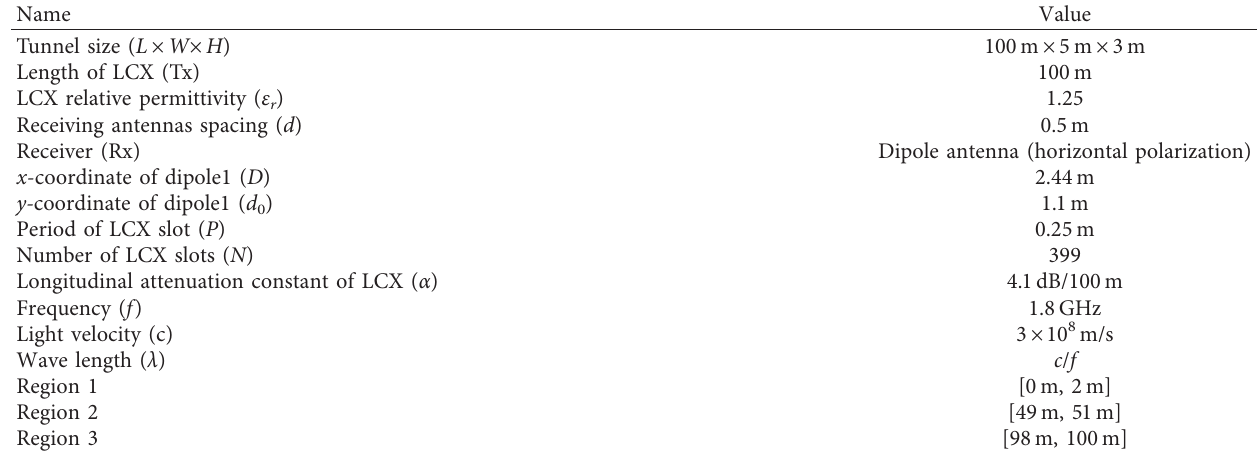
Table 2: Simulations